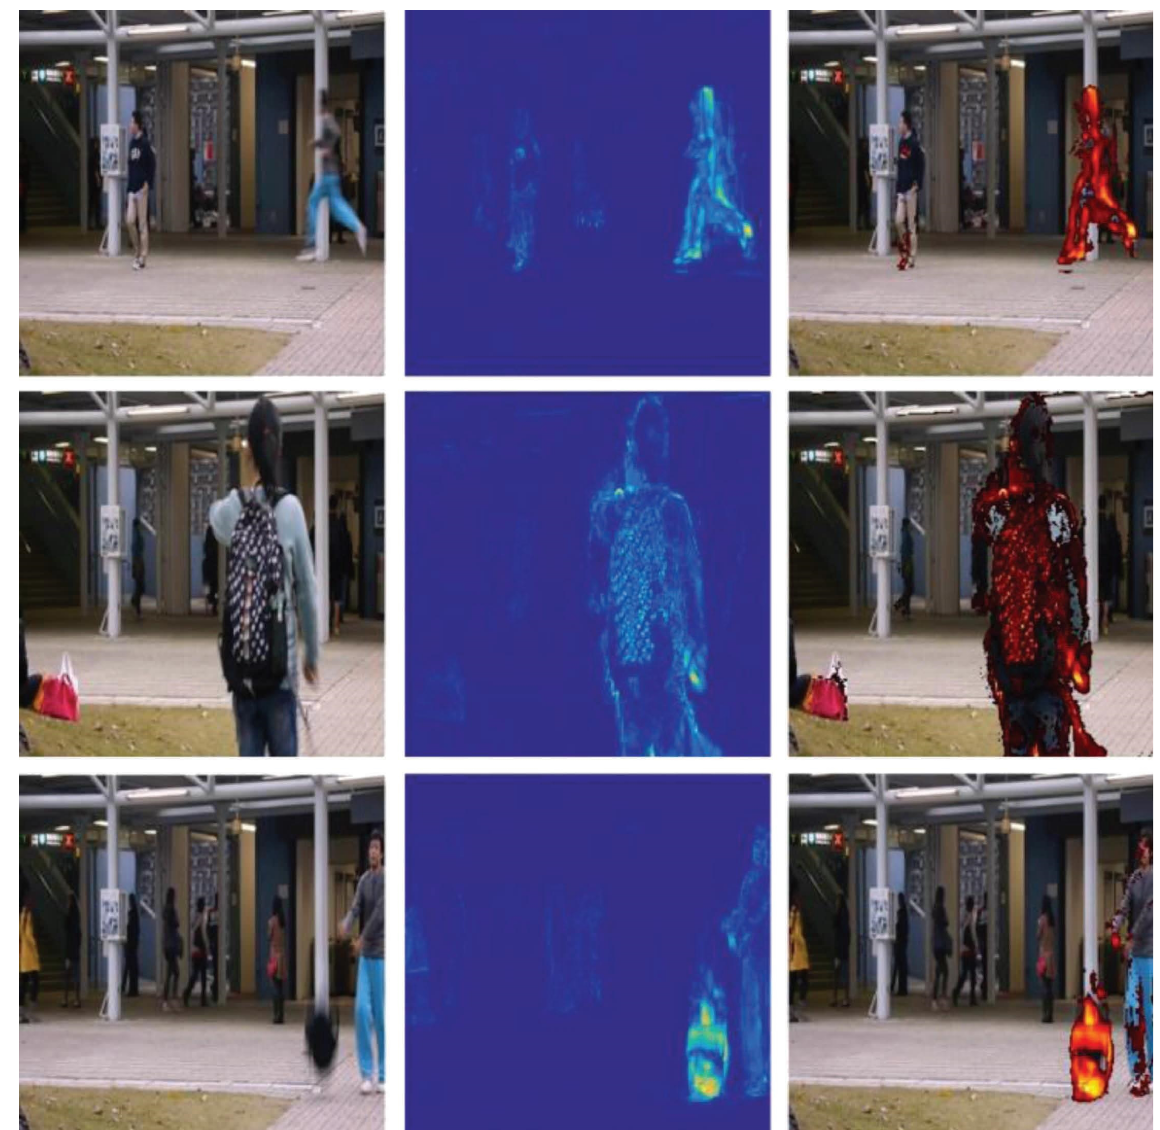
Figure 15: Visualization results of the Avenue